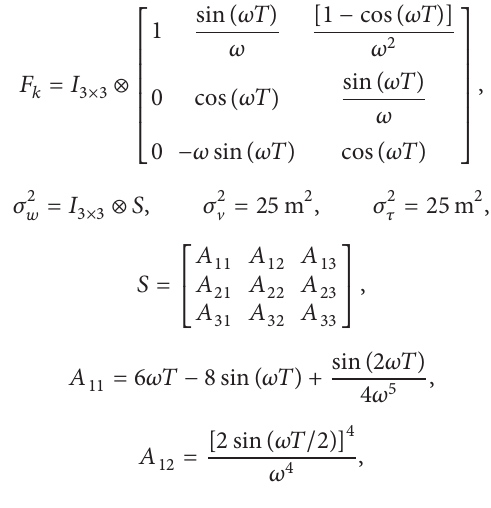
𝑇 = 0.2 s, the probability of stochastic-bias measurement is 1 − 𝜂 = 0.1 . The simulation results are obtained by the proposed adaptive estimation algorithm in Section 4. The root mean square error (RMSE) for the states of position and velocity with different 𝜌 𝑞 (𝑞 = 1, 2, 3) is given in Figures 1–